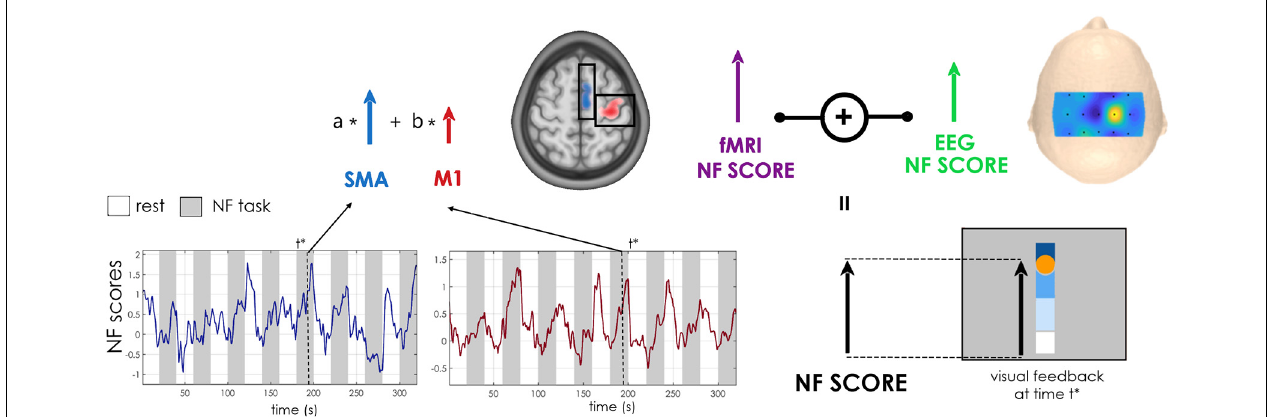
FIGURE 2 | NF calculation schematic. The visual NF at time †* is equal to the average of EEG and fMRI NF scores, updated respectively every 250 ms and 1 s. The fMRI NF score, in turn, is equal to the weighted sum of blood-oxygen-level-dependent (BOLD) activations (contrast NF TASK > REST) in the supplementary motor area (SMA) and primary motor cortex (M1) regions of interest (ROIs) (in blue and red on a normalized anatomical scan, with calibration a priori masks in black). The weights assigned to the two contributions M1 and SMA vary from the first training session ( a = 0.5, b = 0.5) to the second ( a = 0.25, b = 0.75). The EEG score was obtained computing the Event Related Desynchronization (ERD) on a combination of electrodes given by Common Spatial Pattern (CSP) or laplacian filter weights.